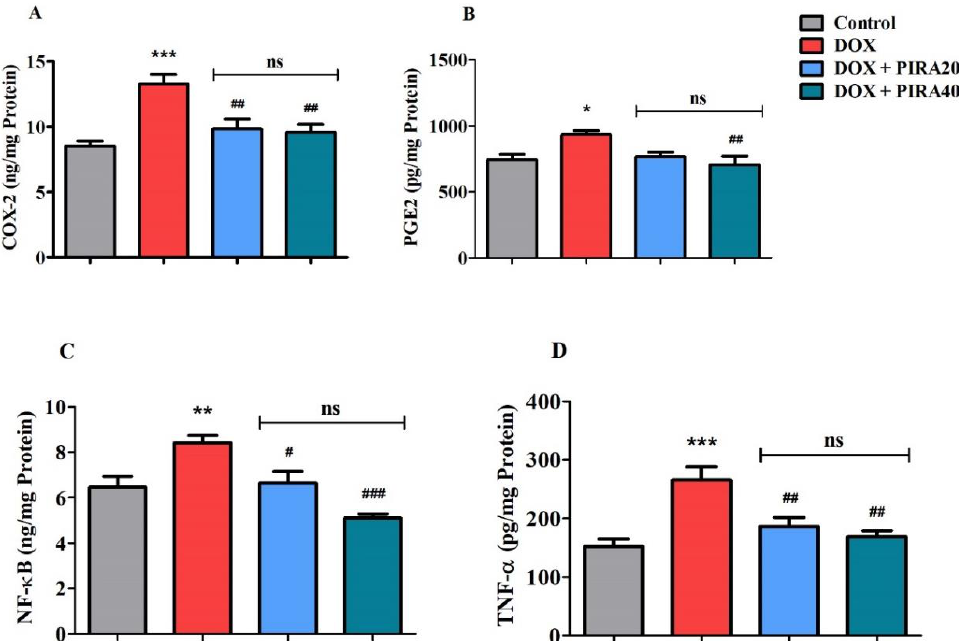
Figure 5. Effect of piracetam (PIRA) on inflammatory parameters ( A ) COX-2, ( B ) PGE2, ( C ) NF- κ B, and ( D ) TNF- α, in doxorubicin (DOX)-induced rat model. The results are expressed by mean ± SEM ( n = 7). A one-way ANOVA [ F (3,24) = 10.65, p < 0.001 for COX-2; F (3,24) = 5.105, p < 0.01 for PGE2; F (3,24) = 12.26, p < 0.001 for NF- κB; F (3,24) = 9.858, and p < 0.001 for TNF- α] was conducted, followed by a Tukey – Kramer multiple comparisons test. * p < 0.05, ** p < 0.01, and *** p < 0.001 as compared to the control group; ns—not significant as compared to the control group; # p < 0.05, ## p < 0.01 and ### p < 0.001 as compared to the DOX-induced